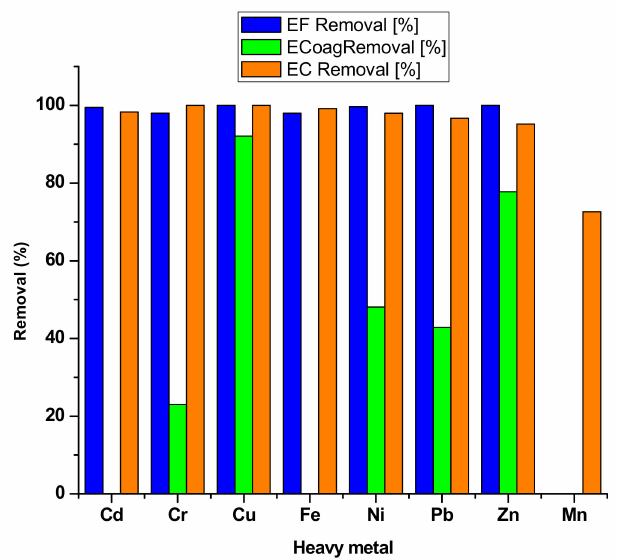
Figure 6. The e ffi ciency of HMIs removal by di ff erent methods such as electrocoagulation (ECoag), electroflotation (EF) and electrochemical removal (EC) (adapted from [118]).